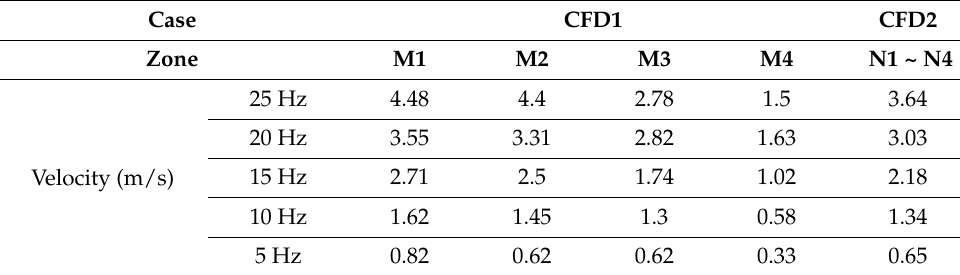
Table 3. Flow boundary conditions for square ceiling